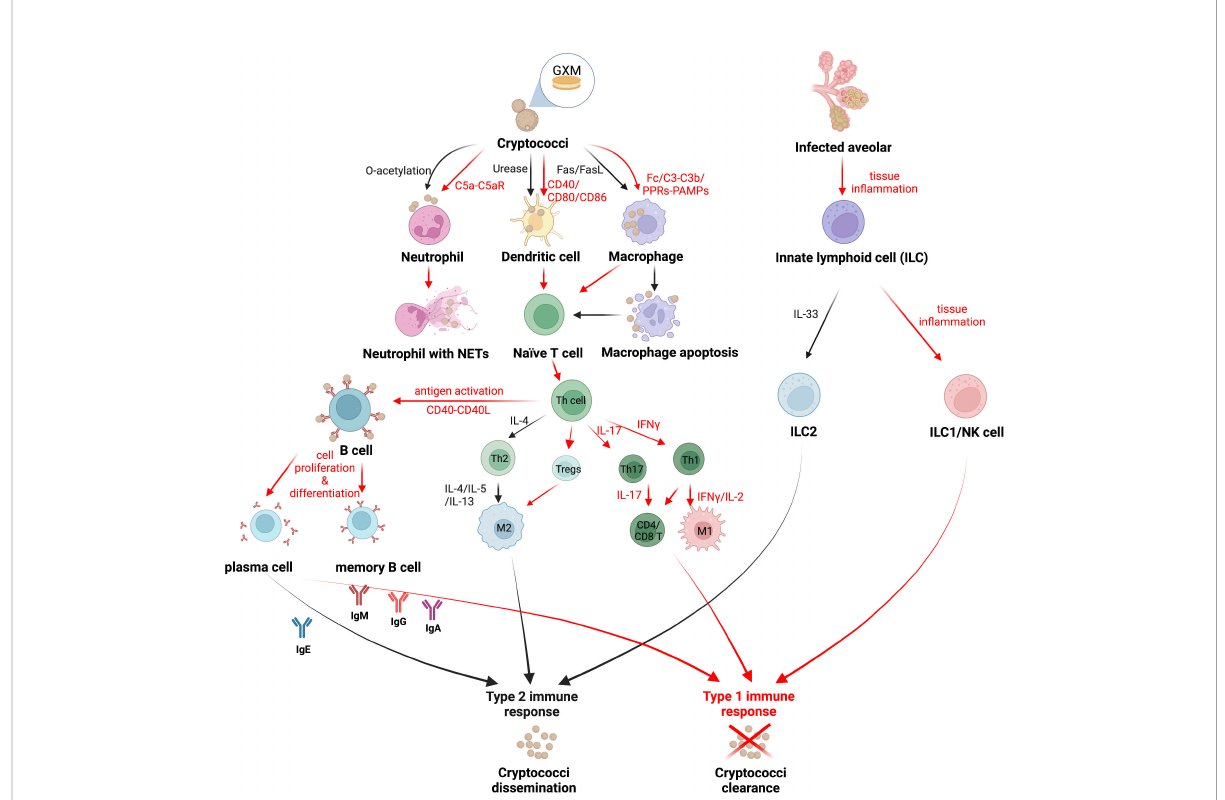
FIGURE 1 The strategy of Cryptococcus immune escaping. Cryptococcus can attenuate the host ’ s correct recognition of the fungal antigen components and escape the immune response mediated by host phagocytes. Red arrows indicate the mechanism by which the host immune system clears Cryptococcus , and black arrows indicate the mechanism by which Cryptococcus escapes host immunity. Created in